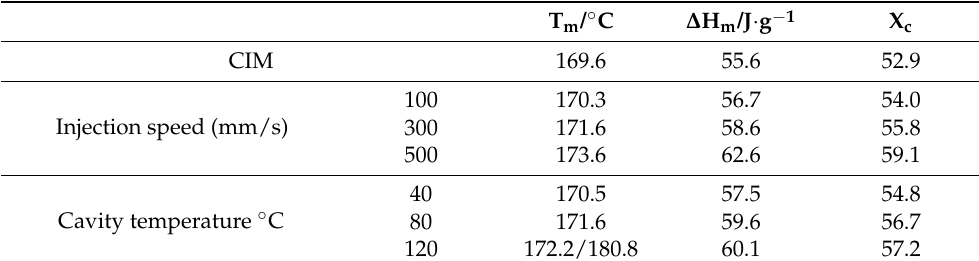
Figure 9. DSC curves of PVDF/GP micro-parts at different injection speeds ( a ) and different cavity temperature ( b ) (GP content: 1 wt%). Table 1. Thermal analyses of PVDF/GP micro-parts at different injection speeds and different cavity